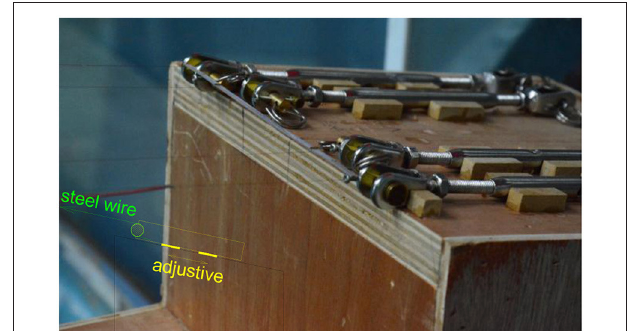
FIGURE 12 | Anchors at end.